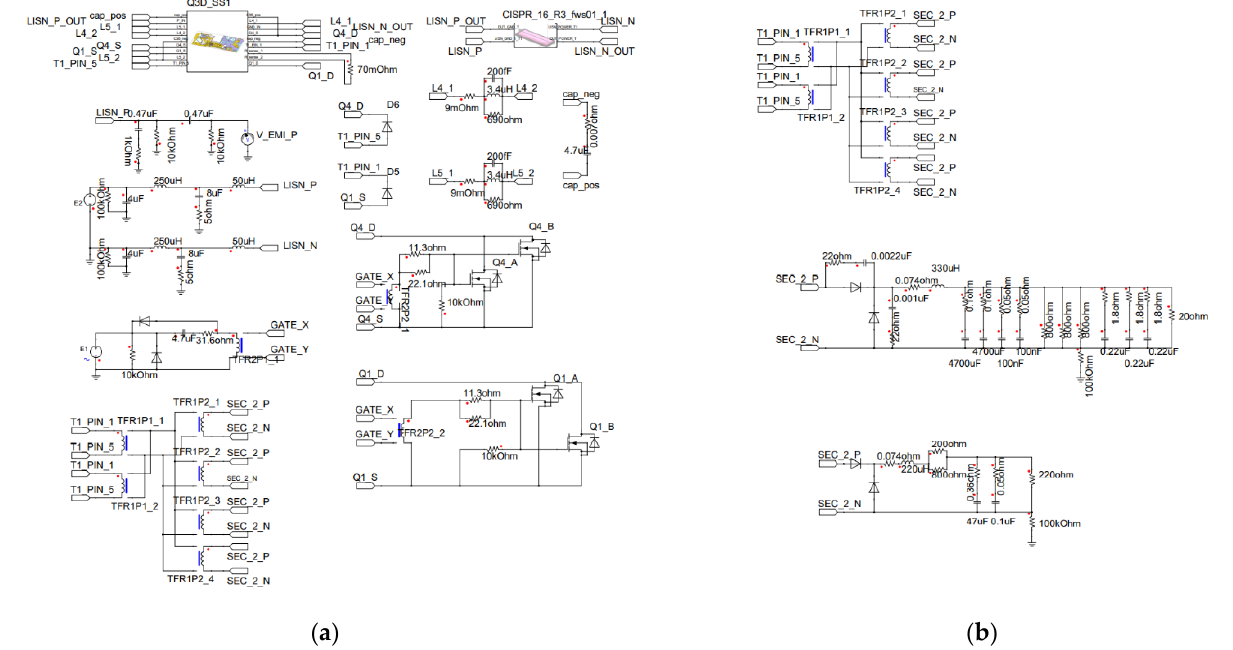
Figure 19. Electrical schematic for transient simulation — Q3D approach: ( a ) LISN and primary side; ( b ) secondary side.